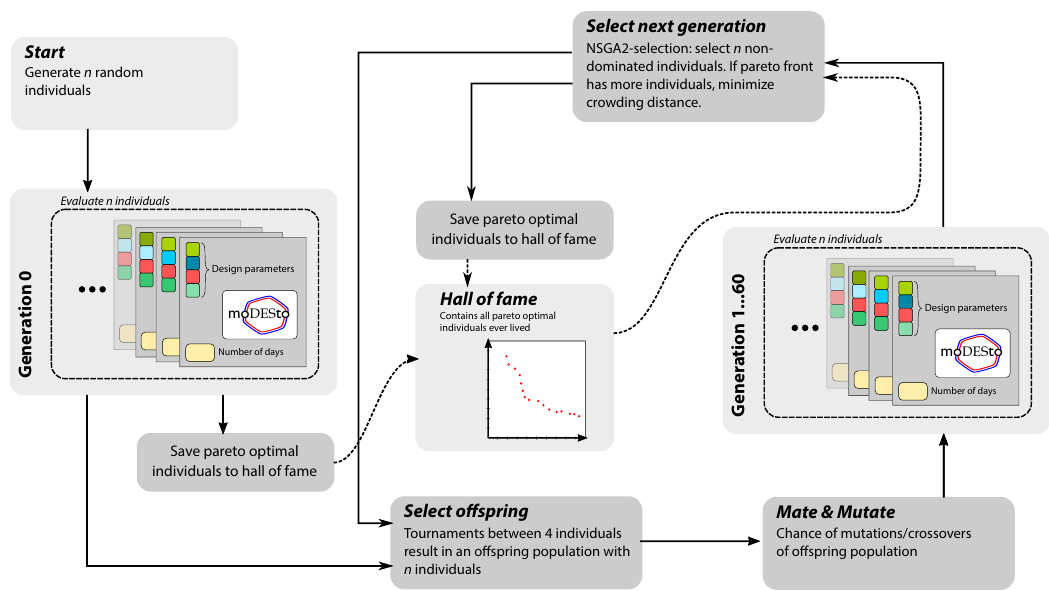
Figure 2. Flow chart illustrating the different steps in the genetic